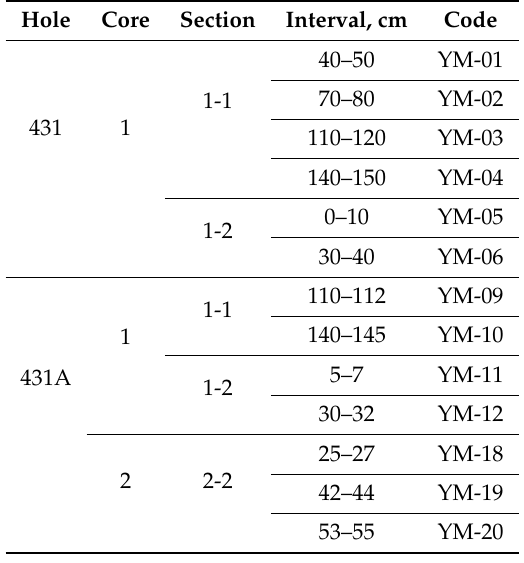
Table 1. Sampling interval in 431 and 431A DSDP Holes from Y¯omei